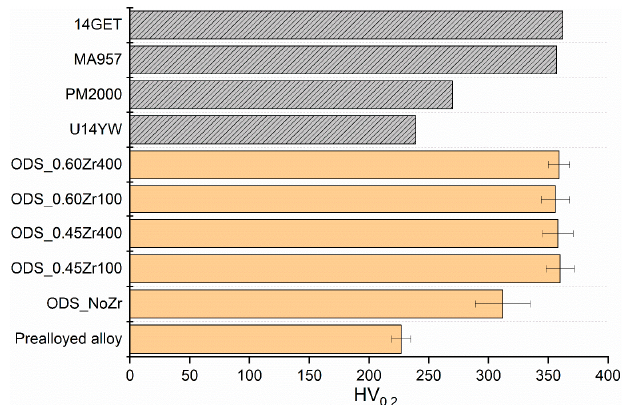
Figure 6. Microhardness of the ODS steels developed in this investigation and some ODS steels from the literature [33–36].